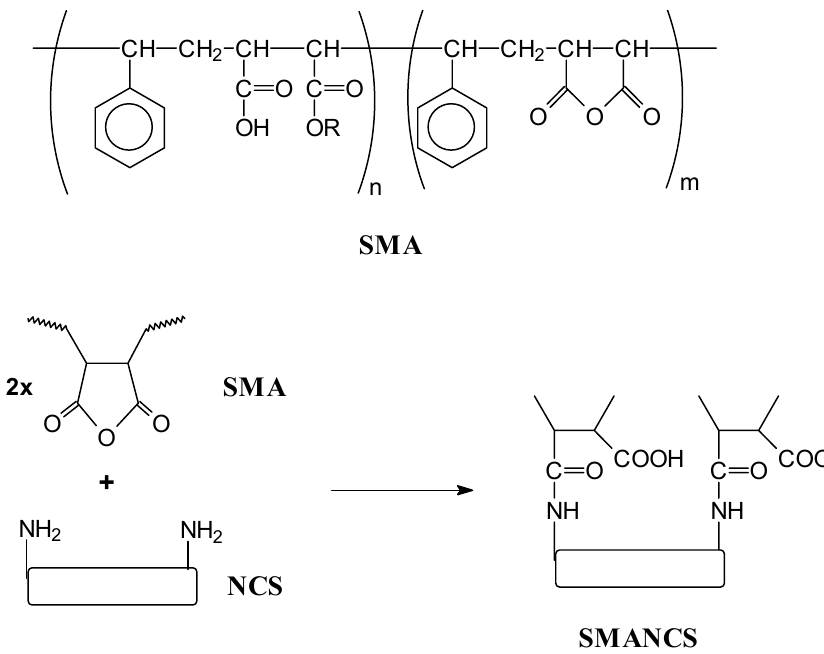
Figure 4. Chemical structure of SMANCS